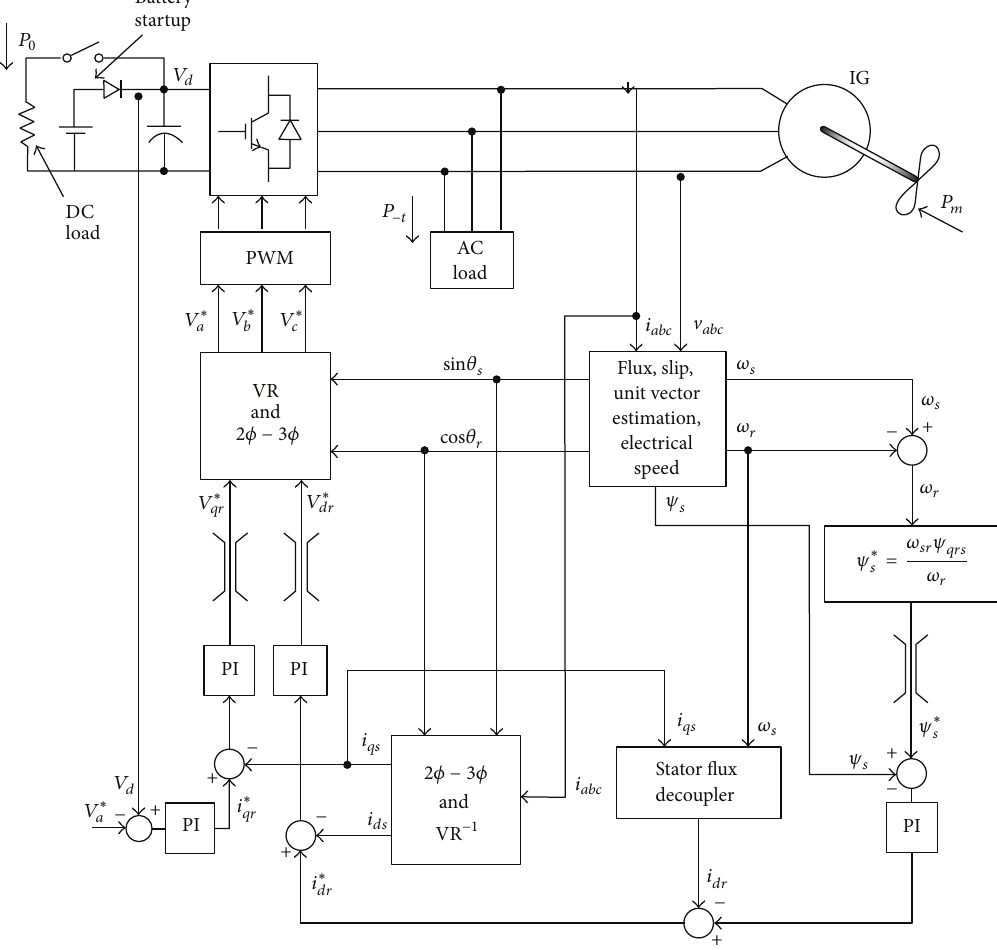
Figure 1: DFIG wind